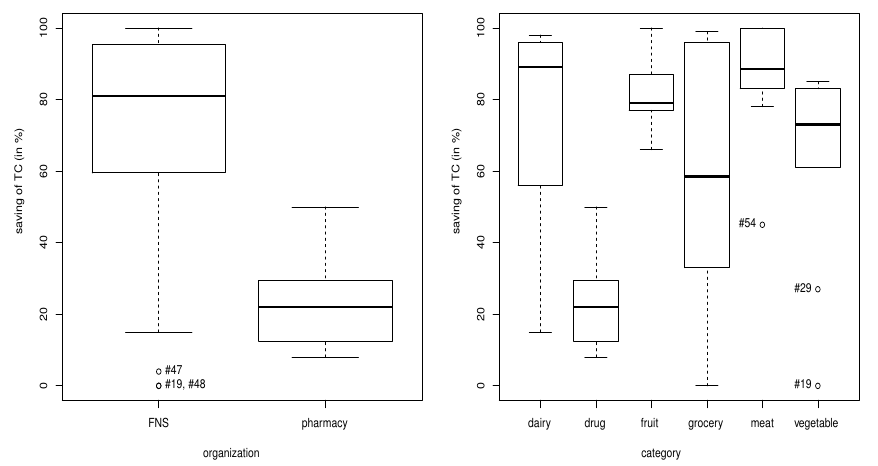
Figure 3. Boxplot for saving of inventory cost (in %) by organization ( first panel ) and category ( second panel